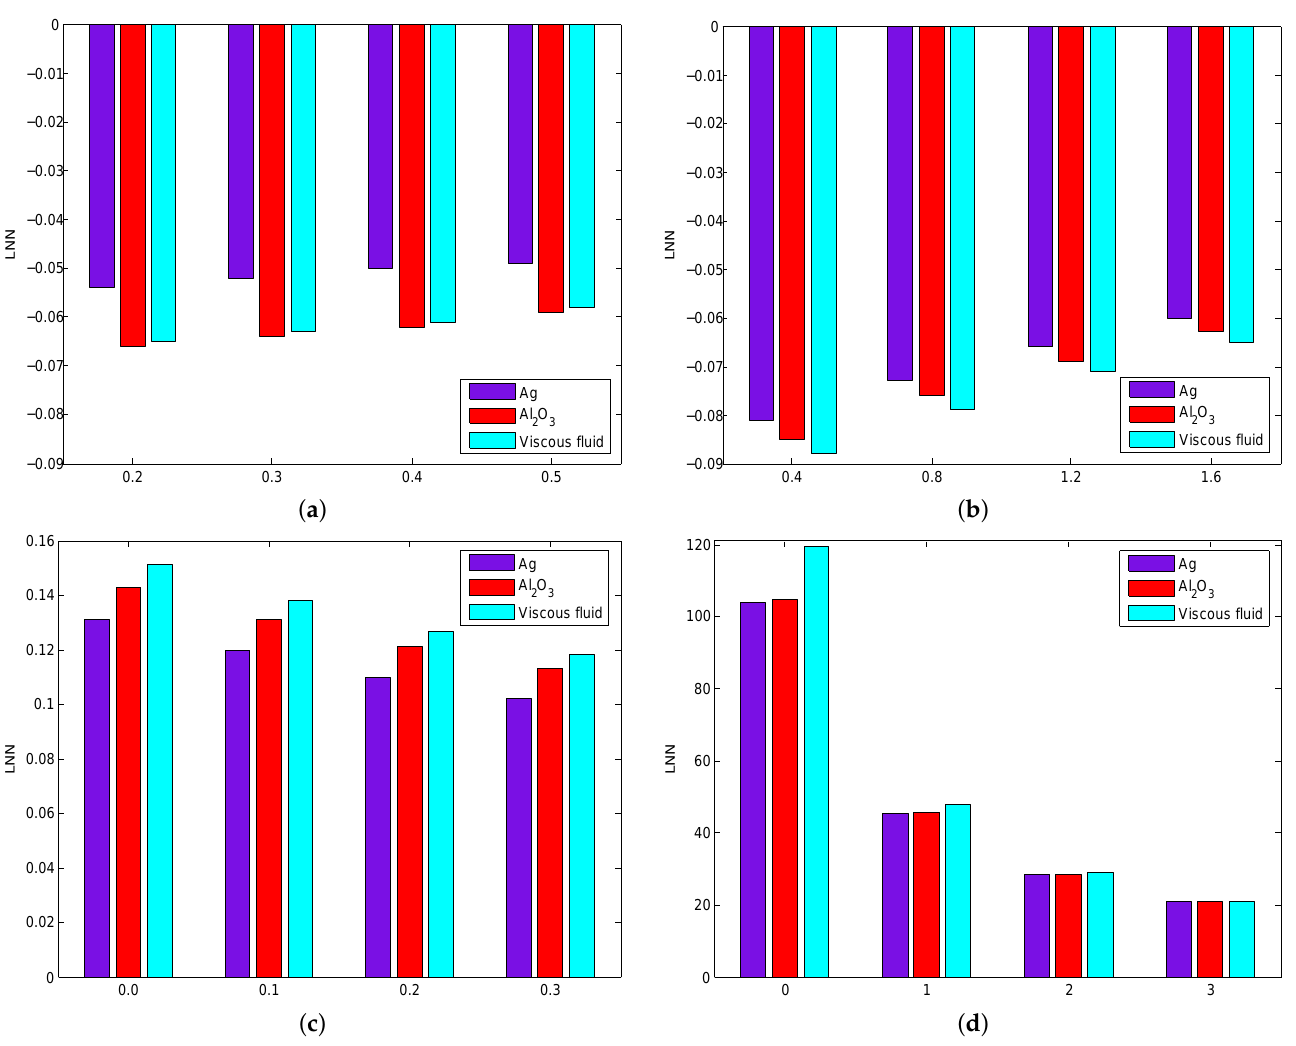
Figure 12. The increasing/declining percentage of LNN on ( a ) λ , ( b ) Fr , ( c ) Ha and ( d ) Rd .